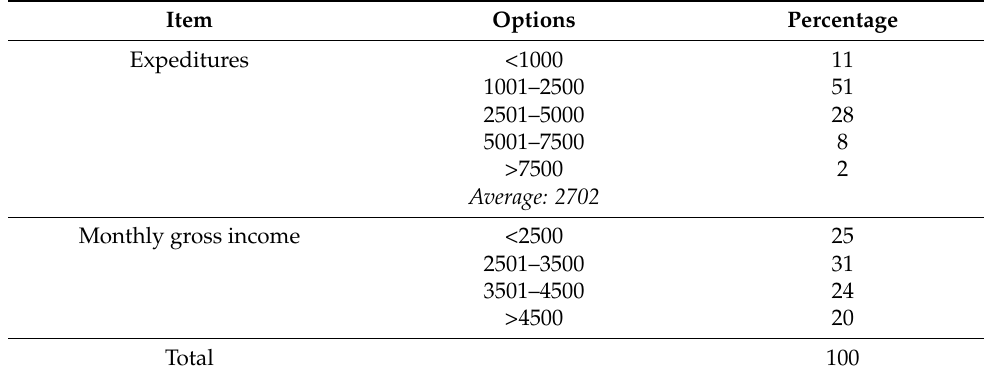
Table 2. Average annual expenditures directly related to hunting and monthly gross income of hunters from the studied Region of Warmia and Mazury. Values expressed in PLN (Polish New